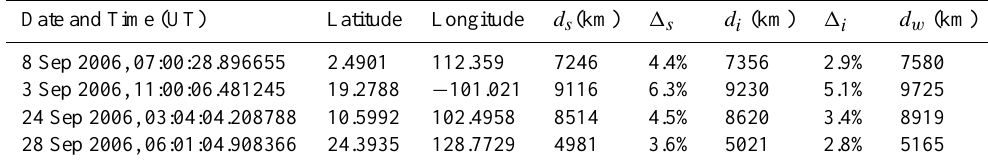
Table 3. Comparison of estimated distances of lightning